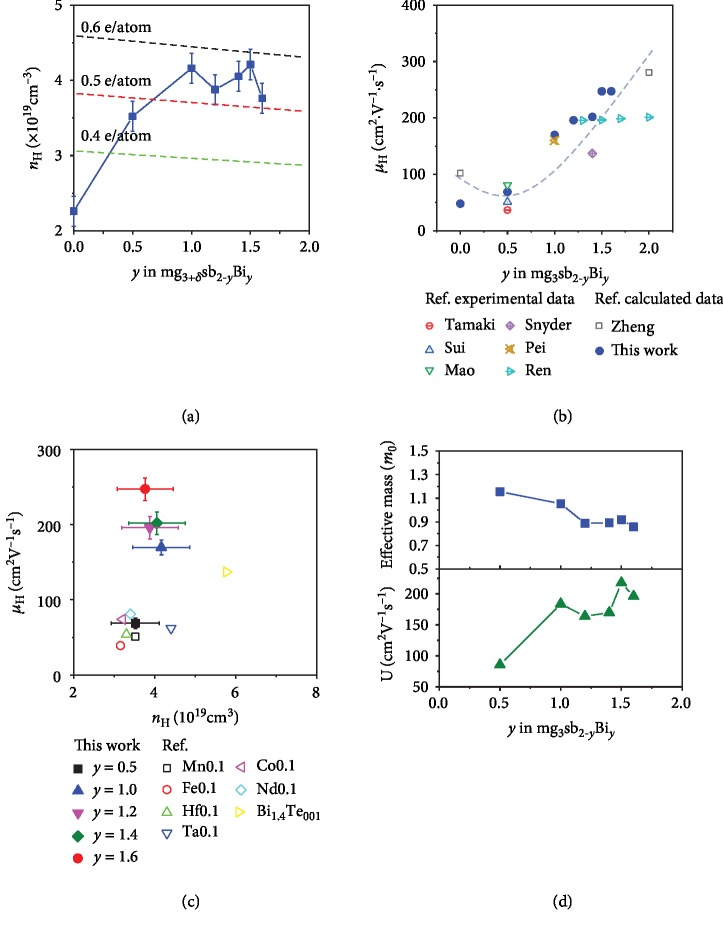
(a) Hall carrier measurement of Mg3+δSb2-yBiy solid solutions (y = 0.5, 1, 1.2, 1.4, and 1.6). (b) Bi content-dependent Hall mobility, theoretical and experimental data from literature as references [5, 7, 8, 18, 28, 35, 39]. (c) Comparison of Hall carrier concentration and mobility in this work and reference reported Mg3+δSb2-yBiy system [8, 38–40]. (d) Weighted mobility and electron effective mass of Mg3+δSb2-yBiy-0.01Te0.01:Mn0.01 solid solutions (y = 0.5‐2.0).